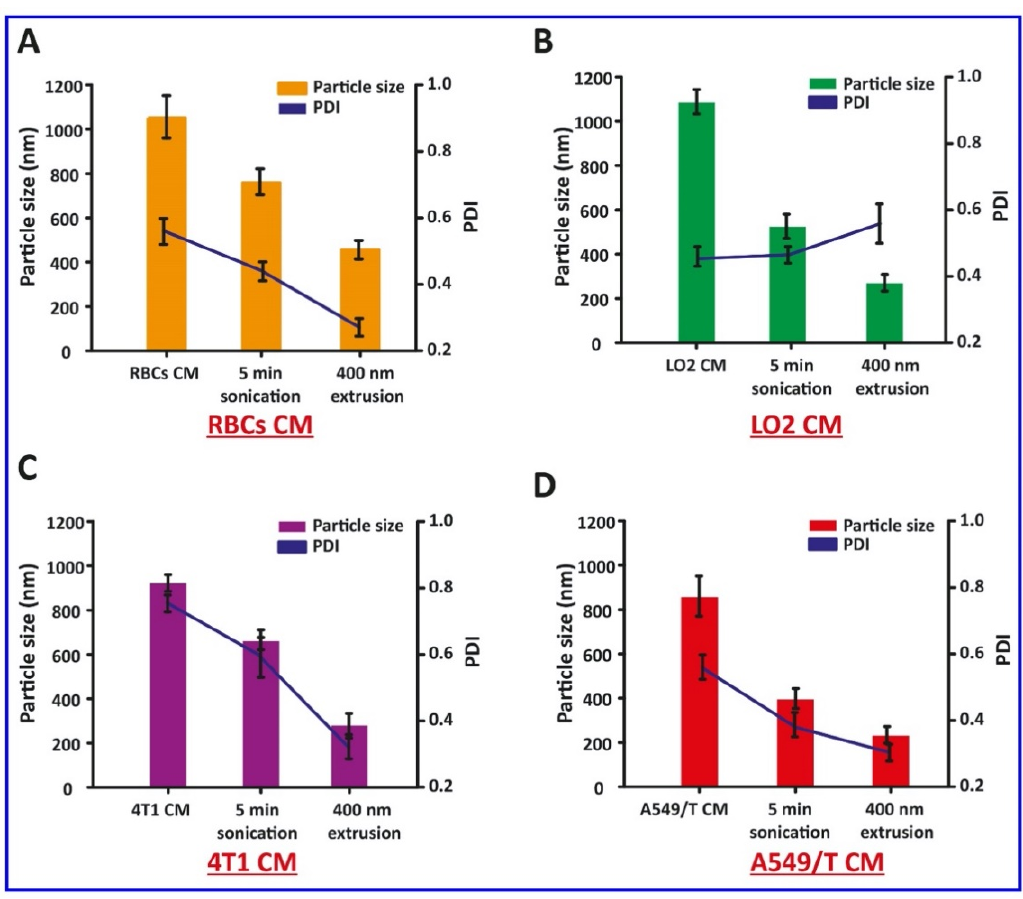
Figure 1. Synthesis and characterization of CBSA and different cell membrane vesicles. ( A ) Synthesis scheme of CBSA by ethylenediamine modification, ( B ) surface charge of native and CBSA, ( C ) SDS- PAGE of native BSA and CBSA, ( D ) surface charge of different cell membrane vesicles.